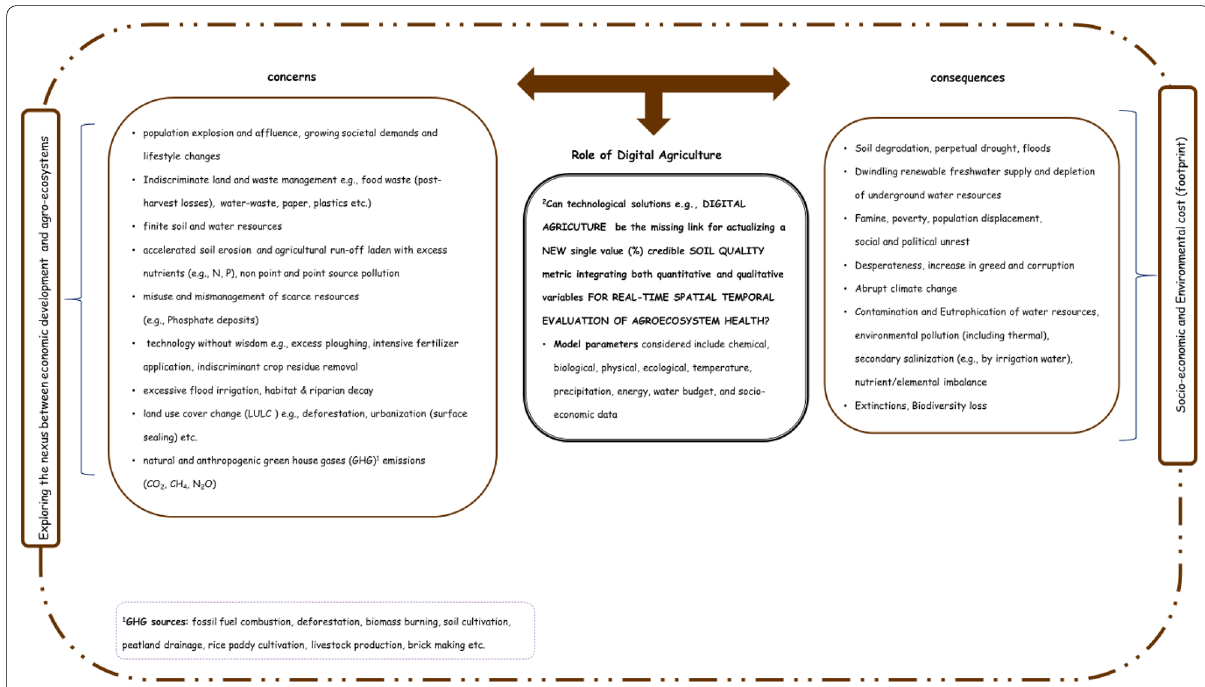
Fig. 1 The synergism between socio economic development, agroecosystems and environmental footprint. 2 The more complicated the problem e.g., soil quality determination, the more data (big-data) required (Modified from Lal (2013), Wyckhuys et al.